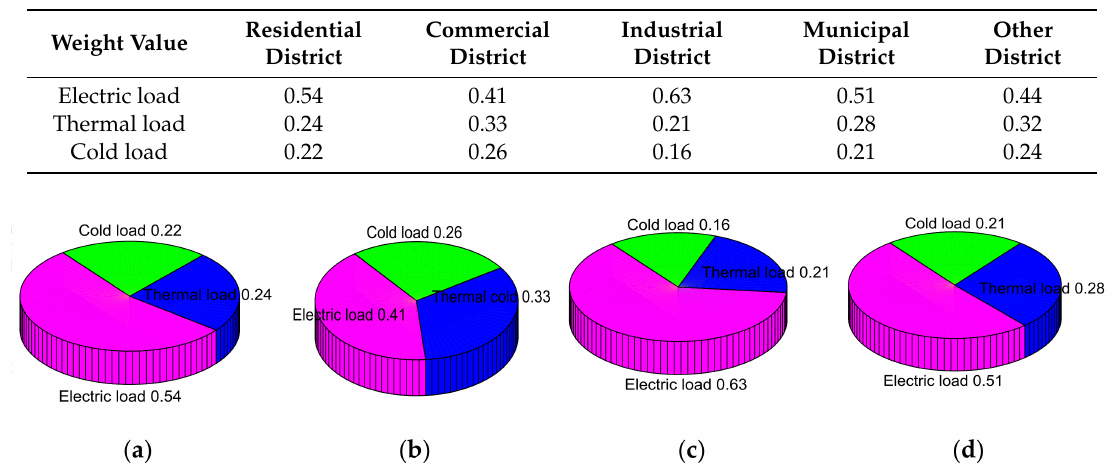
Table 1. The electric/thermal/cold load weight values in various typical functional districts.